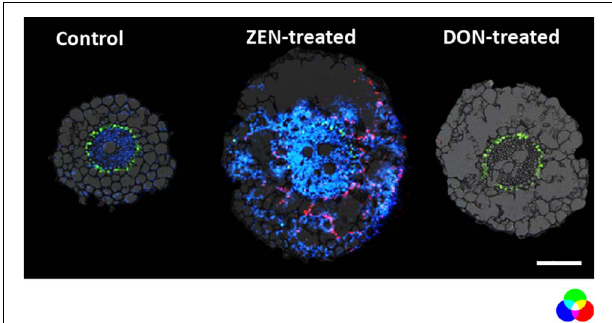
FIGURE 3 | Distribution of metabolites representing the enhanced defensive state of root organ triggered by DON or ZEN treatment. RGB overlay of m/z images of DAG (42:5) [M + K] + m/z 737.5481 (green), feruloylagmatine [M + H] + m/z 307.1765 (blue), kaempferol-rhamnoside-glucoside [M + Na] + m/z 617.1478 (red) with the optical images. The distribution of DAG (42:5) (green) is homogeneous regardless of the treatment. Its ion image is well correlated with the optical image in the endodermis. The AP-SMALDI MS images were obtained at 7 µ m imaging step size and normalized to the total ion current on a 0-60% intensity scale for feruloylagmatine (blue) and kaempferol-rhamnoside-glucoside (red) and 0-40% intensity scale for DAG (42:5). Scale bar: 200 µ m.